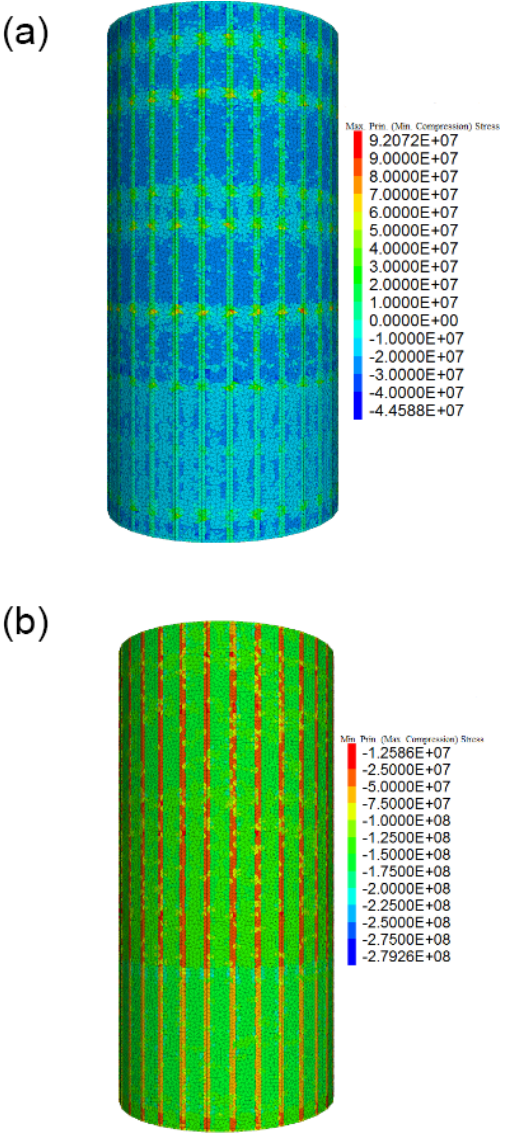
Table 13. Constitutive parameters for matrix.